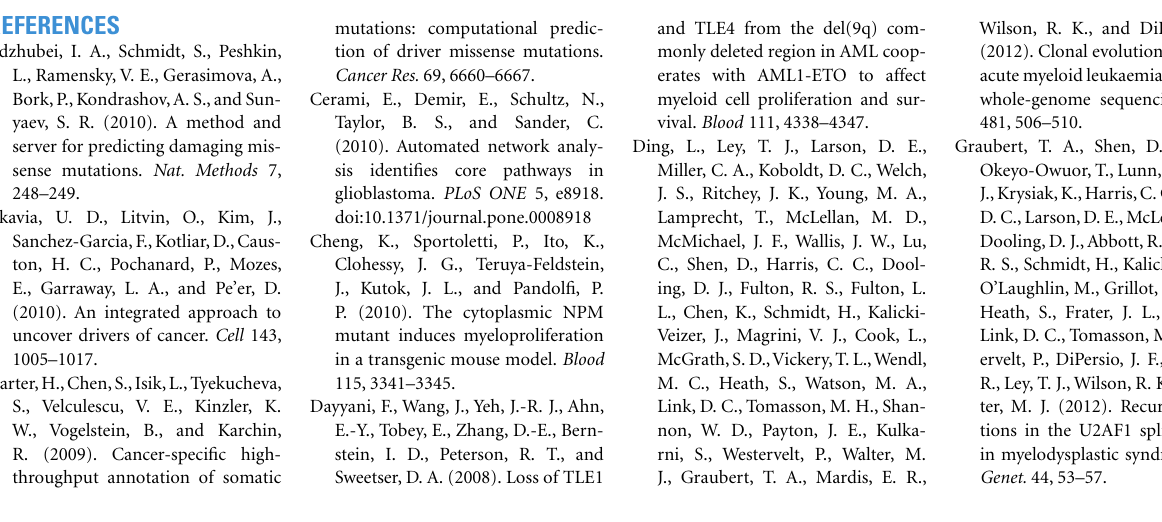
Table S1 | Catalog of all the genes with molecular genetic abnormalities in adultAML as detected by NGS technologies. The 290 genes listed in this table were found in one or more tumor samples.This table includes also the nine genes whose mutations were relapse-specific and absent in the additional 200 primary AMLs considered for testing recurrently mutated genes (Ding et al.,